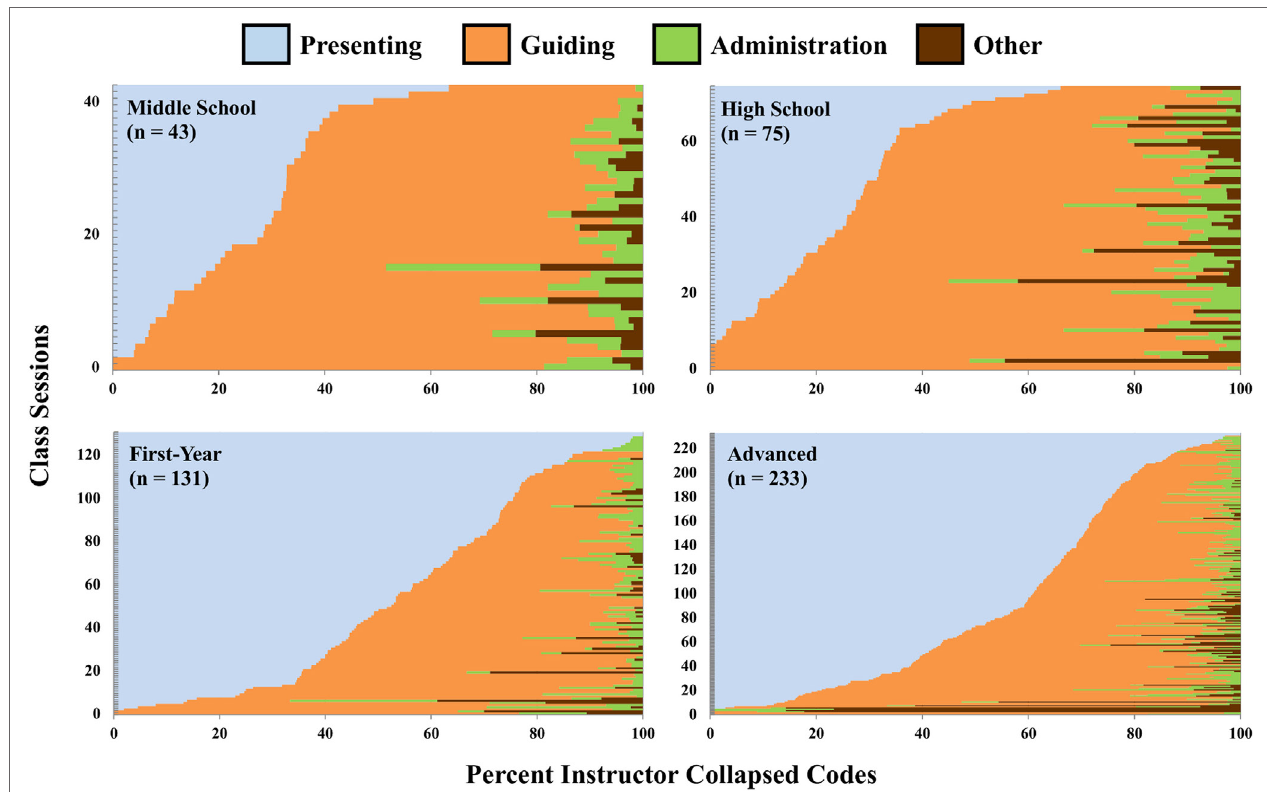
FigUre 3 | Percentage of instructor collapsed Classroom Observation Protocol for Undergraduate STEM codes for middle school, high school, first-year, and advanced university classes. Each horizontal bar represents a different class session. The classes are ordered by the collapsed code Instructor Presenting. Figure 1 describes the Instructor Collapsed